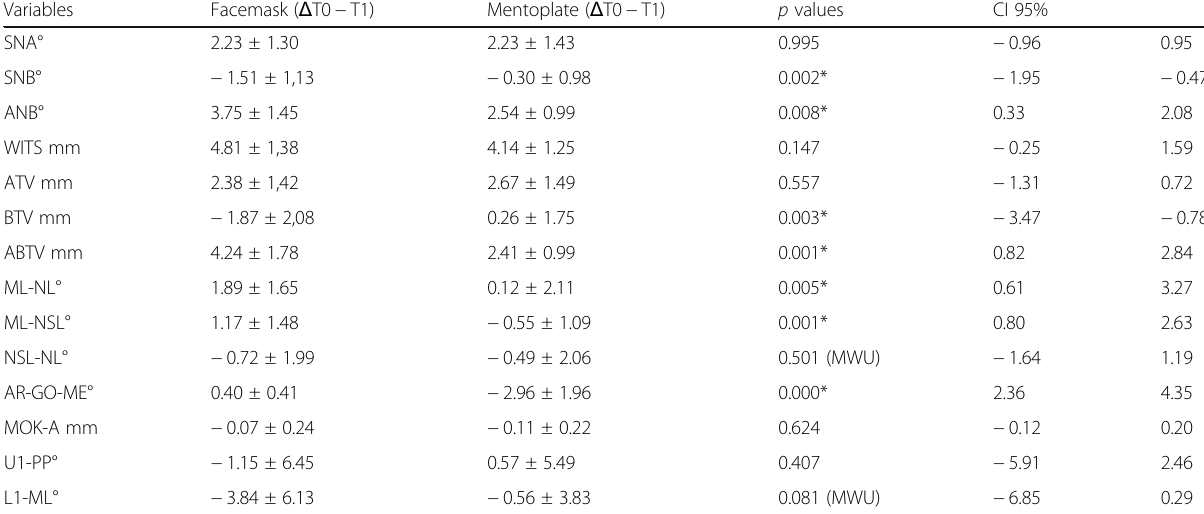
Table 7 Group differences between the facemask and Mentoplate